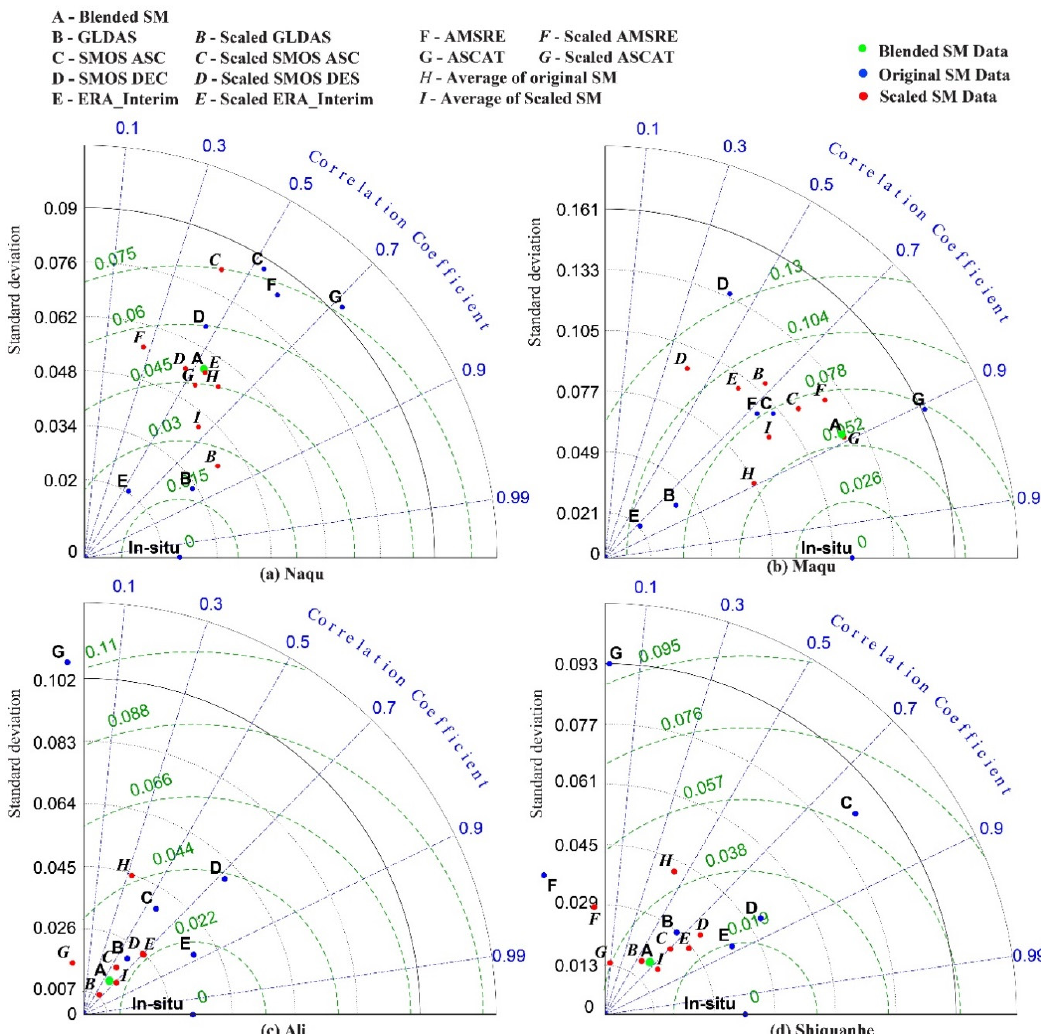
Figure 10. Taylor diagram illustrating the statistics of the inter-comparison between the in situ measurement and the 13 sets of different satellite SM products, over ( a ) Naqu; ( b ) Maqu; ( c ) Ali; and ( d ) Shiquanhe. The original SM data were represented by the blue markers; the scaled and equal weighting average of the SM datasets were represented by the red markers; the blended SM was represented by the green marker. The original SM data were symbolled with the bold BCDEFG , while the scaled SM were with the italic bold BCDEFG .